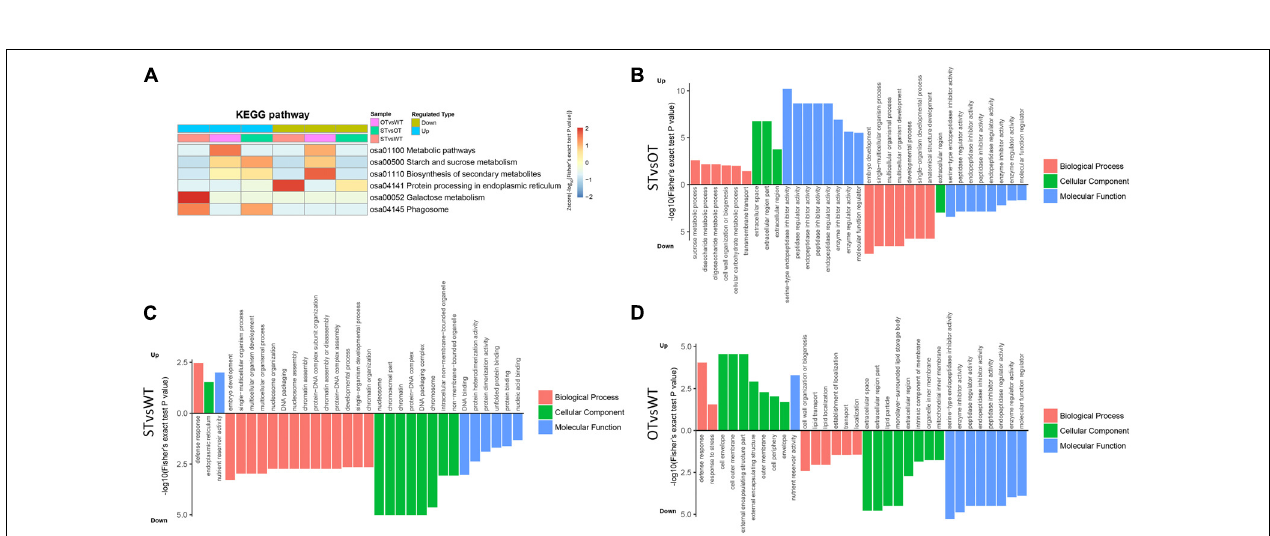
FIGURE 3 | Proteome analysis of WT, ST, and OT seeds (three biological replicates per genotype). (A) Reproducibility of the proteome data. (B) Number of DEPs. (C) Cluster analysis of DEPs.